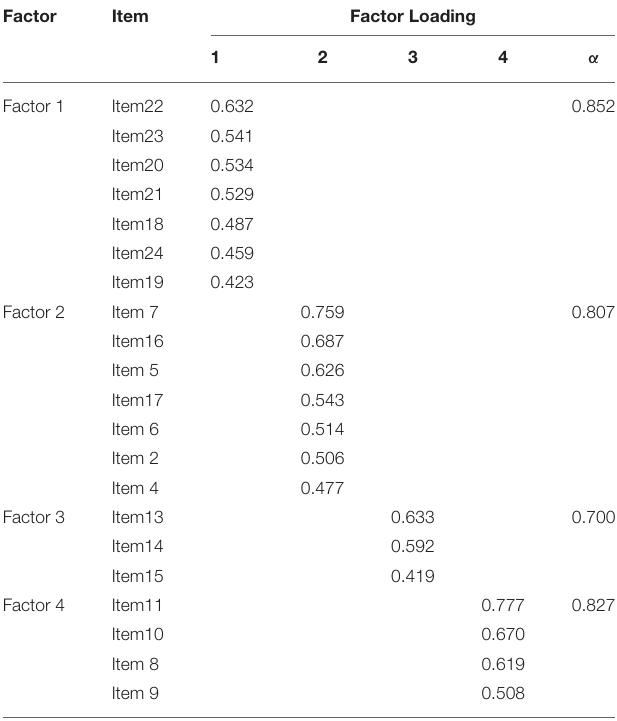
TABLE 2 | Factor loadings and reliability of the EFLLWMEQ ( N =